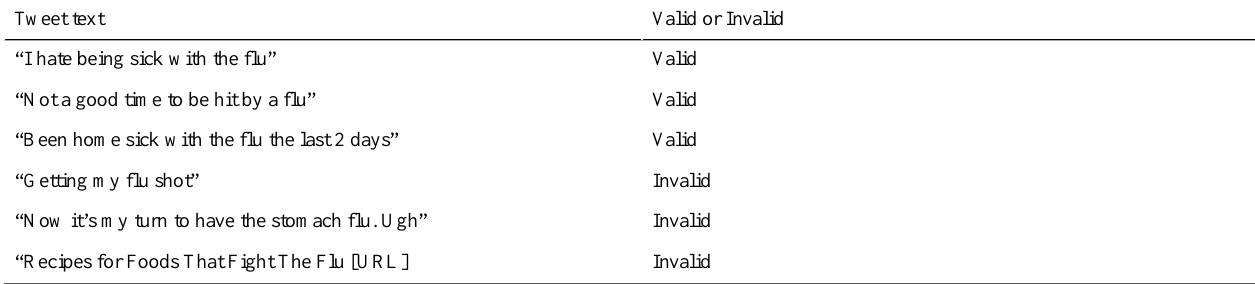
Table 1. Examples of valid and invalid tweets from the machine-learning classifier.